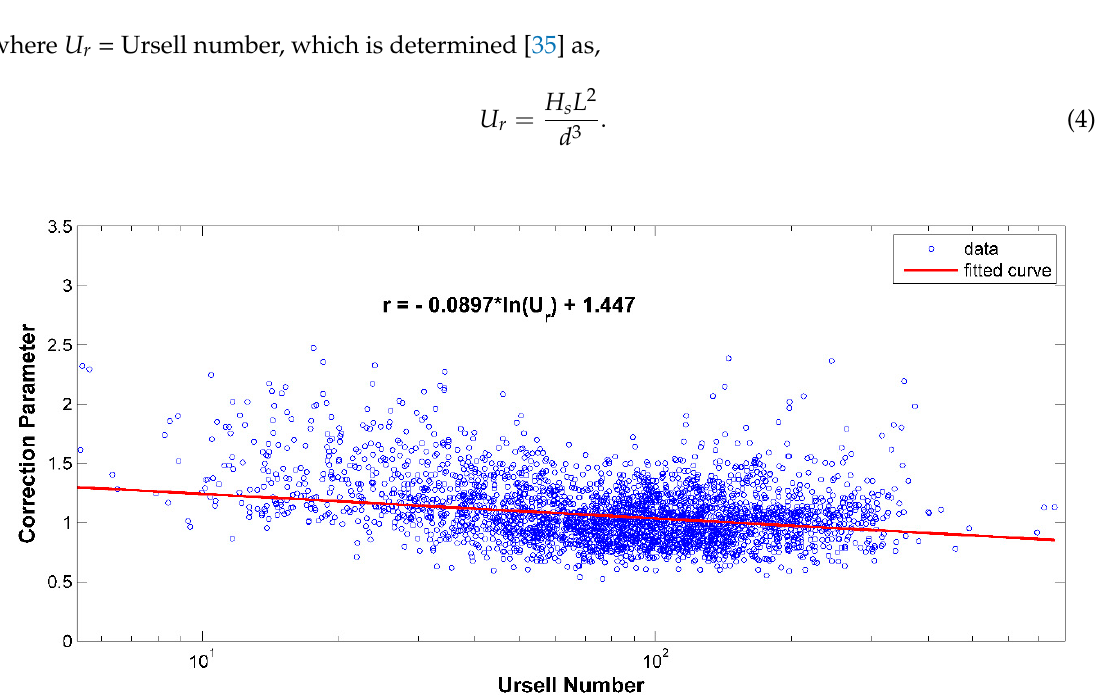
Figure 4. Relationship between the correction coefficient and the Ursell number.